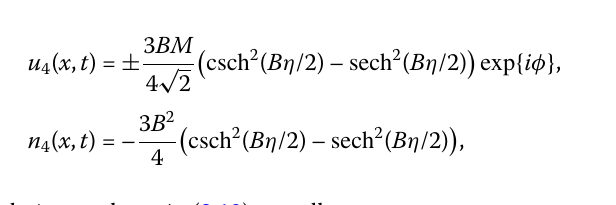
Using the formula csch 2 ( α ) – sech 2 ( α ) = 4 csch 2 (2 α ), we can